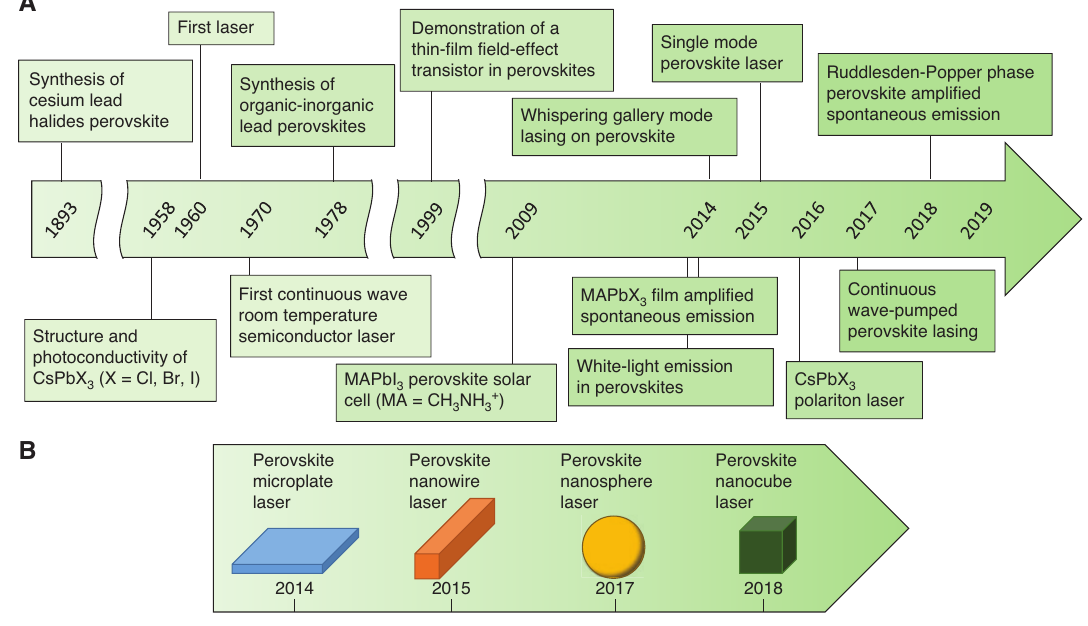
Figure 1: History of lasers based on halide perovskites. (A) General milestones from halide perovskite synthesis to the application for lasers [1–14]. (B) Evolution of single-particle perovskite lasers [8,